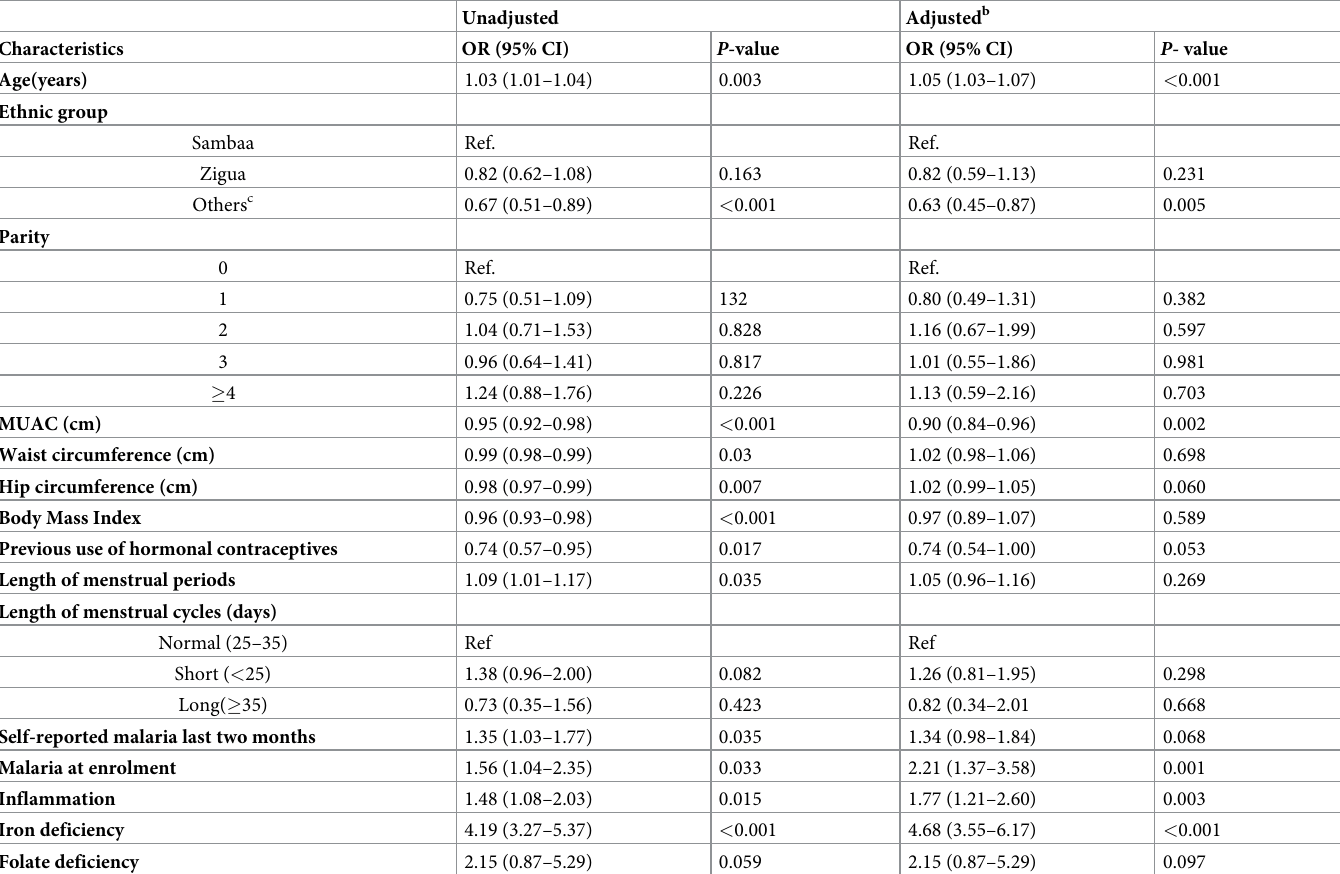
Table 2. Risk factors associated with preconception anemia among women in rural north eastern Tanzania (N = 1125) a .